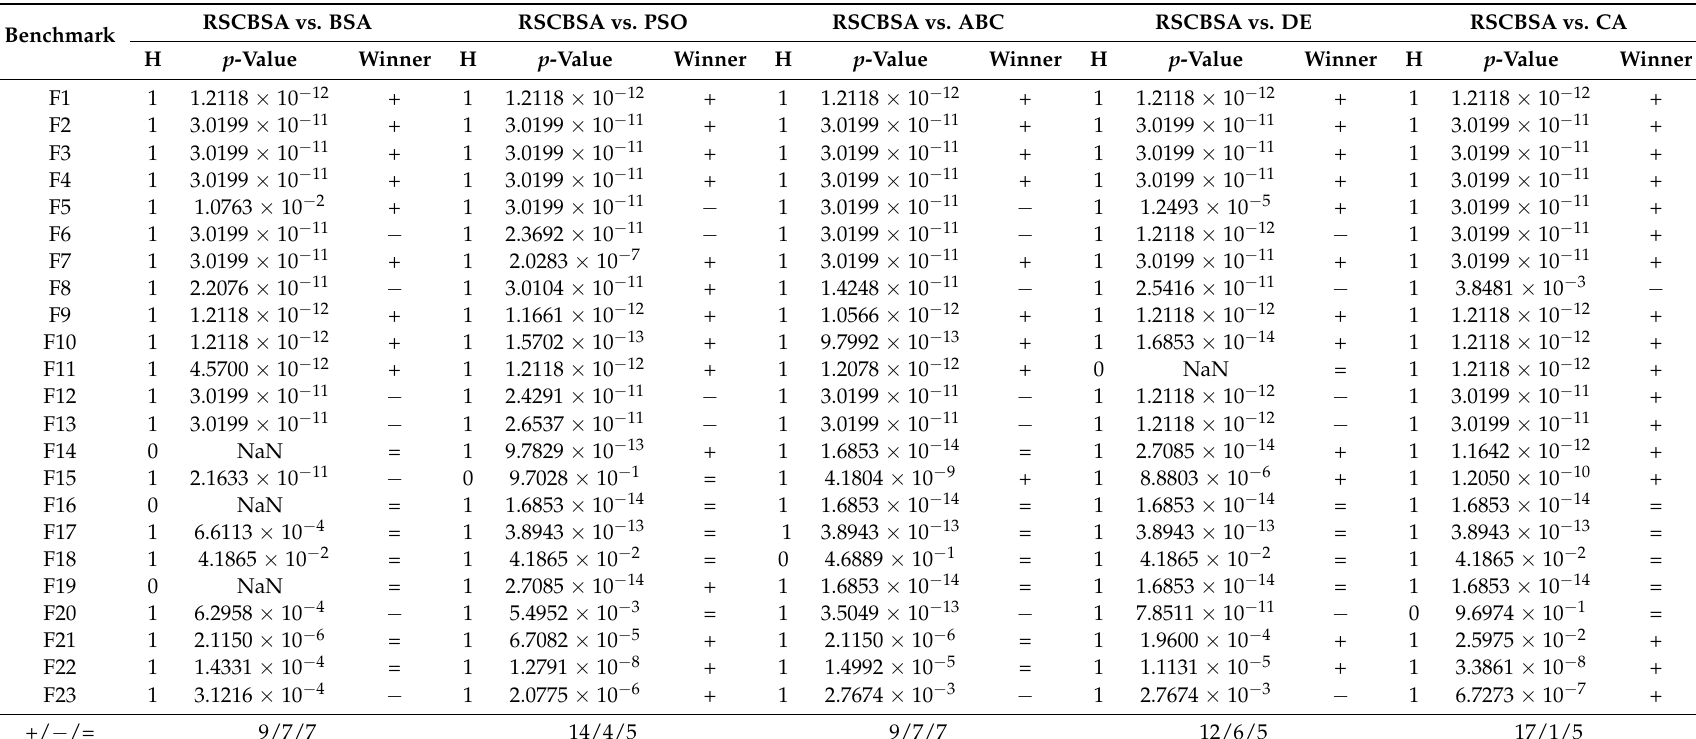
Table 7. Test statistical results of Wilcoxon rank-sum